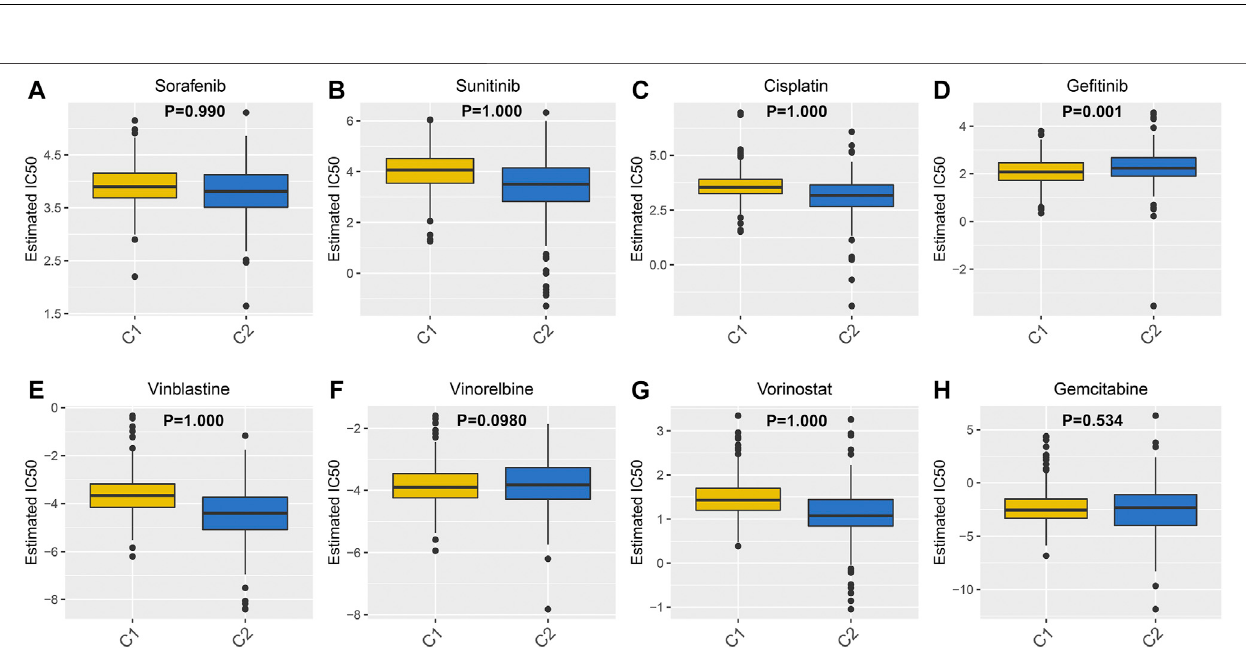
FIGURE 5 | Differences in sensitivity to chemotherapy drugs between two ccRCC molecular subtypes. The box plots depicting the estimated IC50 values for (A) Sorafenib (B) sunitinib (C) Cisplatin (D) ge fi tinib (E) Vinblastine (F) Vinorelbine (G) Vorinostat and (H) Gemcitabine in ccRCC samples from the two molecular subtypes.